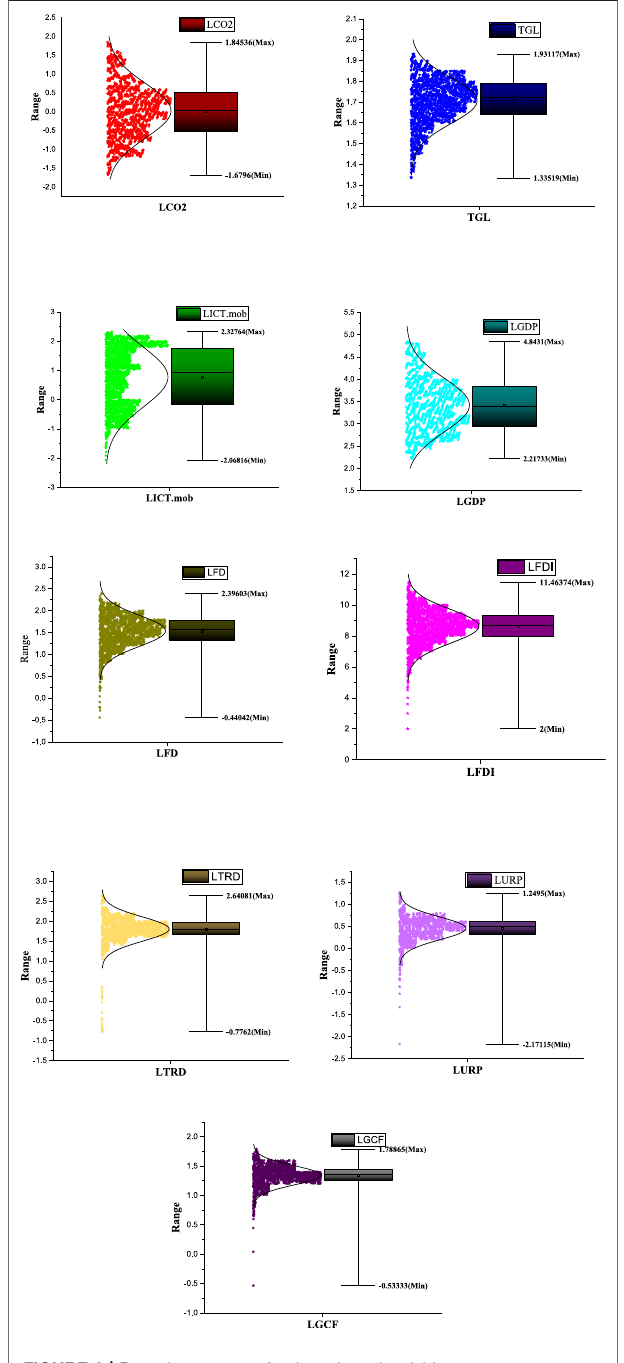
FIGURE 3 | Box – plot summary for the selected